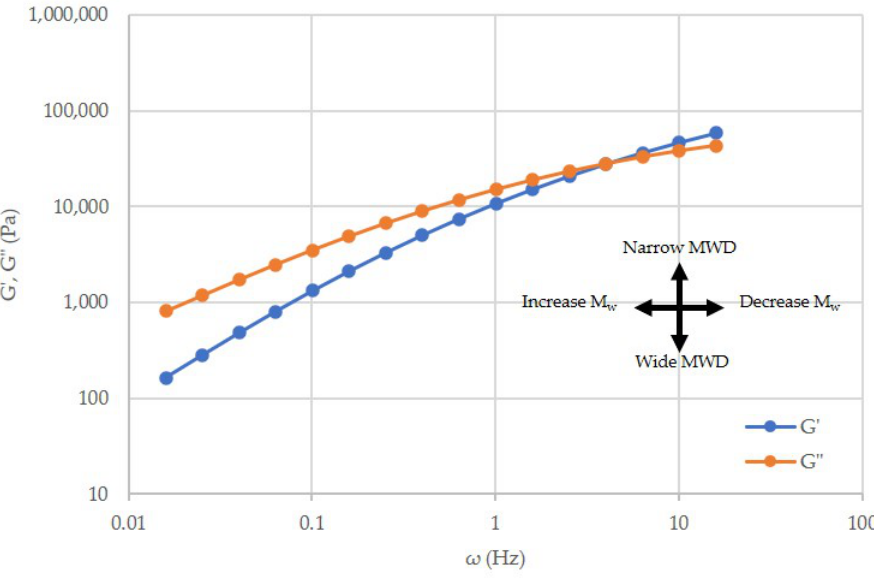
Figure 1. G (cid:48) and G (cid:48)(cid:48) for unprocessed polypropylene, showing the crossover point where G (cid:48) = G (cid:48)(cid:48) ; Figure 1. G’ and G” for unprocessed polypropylene, showing the crossover point where G’ = G”; modeled after modeled after [10,26].